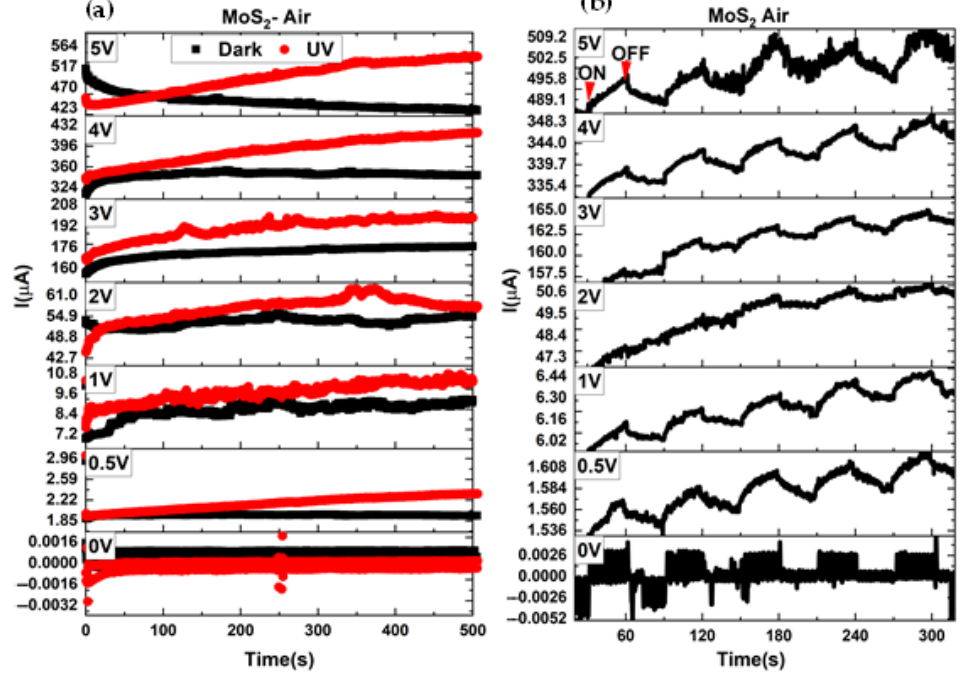
Figure 9. ( a ) Photocurrent behavior with time of MoS 2 under dark and UV illumination conditions in air, and ( b ) the on–off time-resolved photoresponse of MoS 2 thin film under bias voltages of 0–5 V. To check the photocurrent time and the on–off behavior of the MoS 2 photodetector